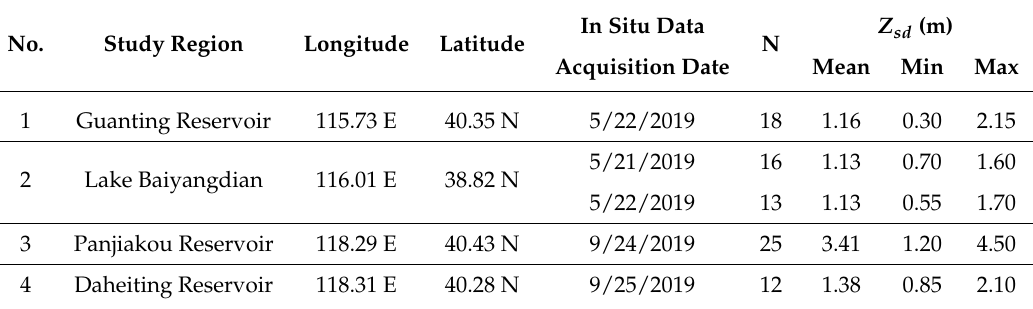
Table 1. Waterbody names, the central longitude and latitude of the study areas, in situ data acquisition date, number of samplings (N), and Z sd values for the field measurements. No. Study Region Longitude Latitude